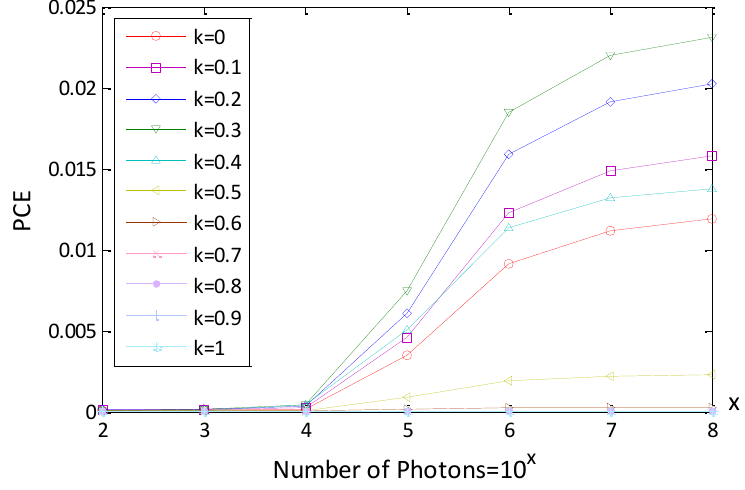
Figure 5. PCE values with various k values using true class image (Lena Bayer image).